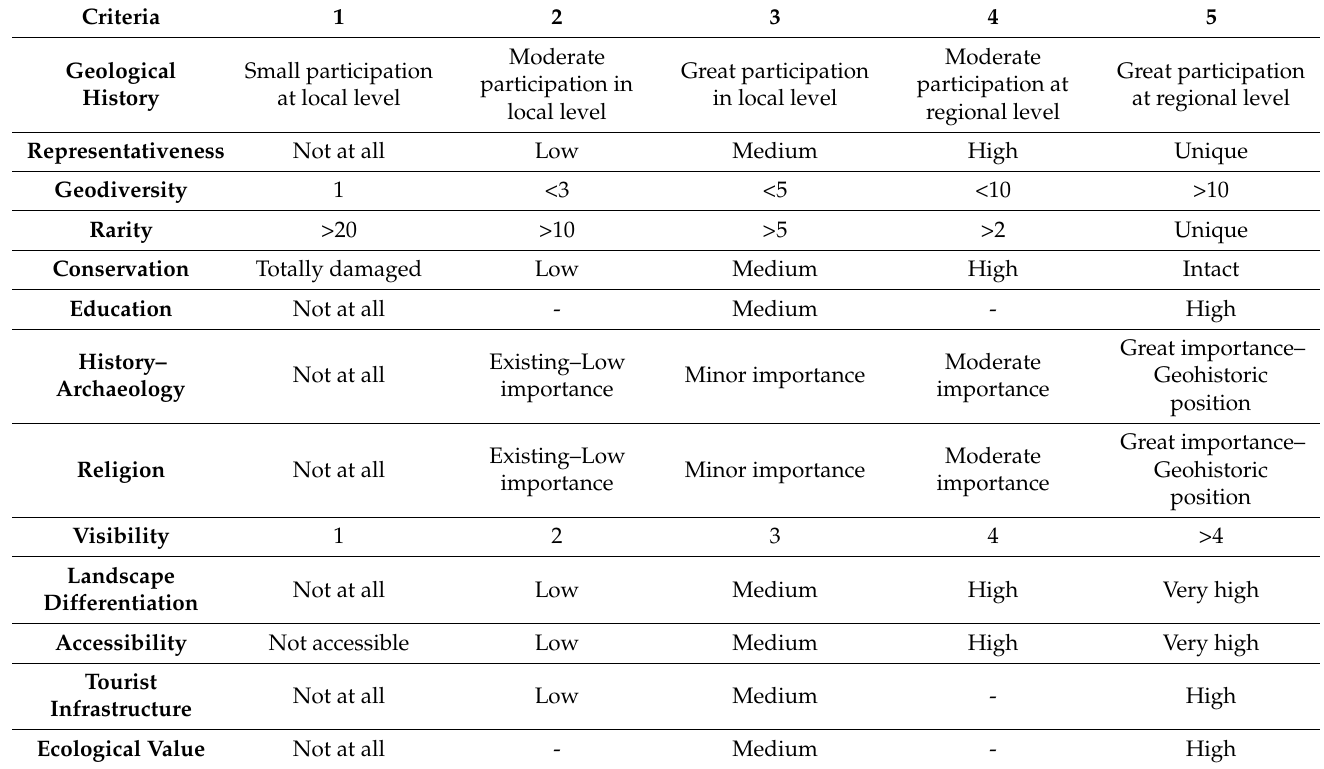
Table 1. Quantitative grading of the criteria